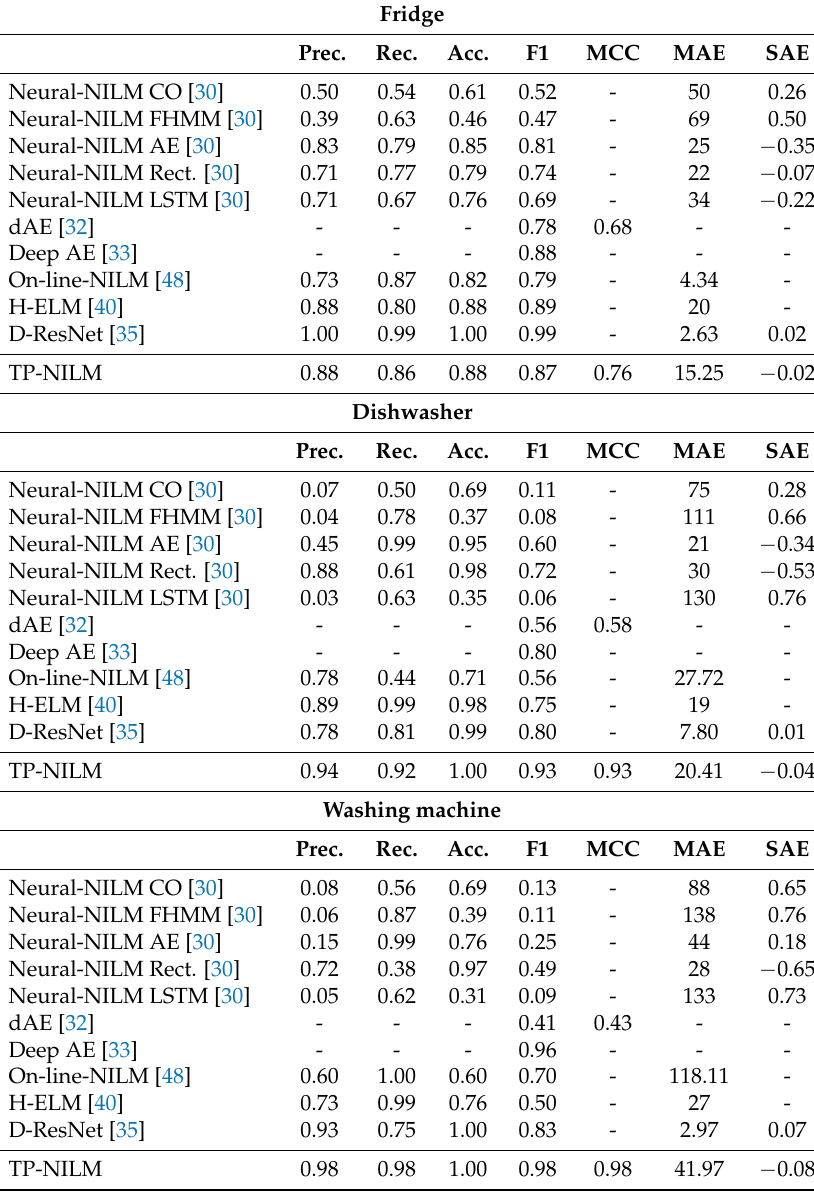
Table 6. Performance comparison for the seen case on the UK-DALE dataset. The models used for comparison are based on Combinatorial Optimization (Neural-NILM CO), Hidden Markov Model (Neural-NILM FHMM, ON-line-NILM), Convolutional Neural Network (Neural-NILM AE, Neural-NILM Rect., dAE, Deep AE, D-ResNet), Recurrent Neural Networks (Neural-NILM LSTM) and Extreme Learning Machine